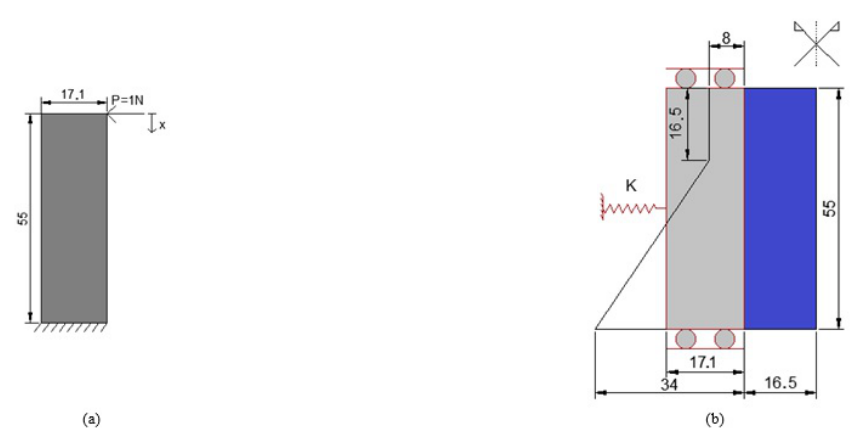
Figure 5. (a) Timoshenko beam clamped-free of unitary width, with its dimensions in meters. (b) Left part of the 2D double- piston-acoustic cavity system superimposed on the left part of the lock-tank system, with its dimensions. Both systems are symmetrical. Measured in